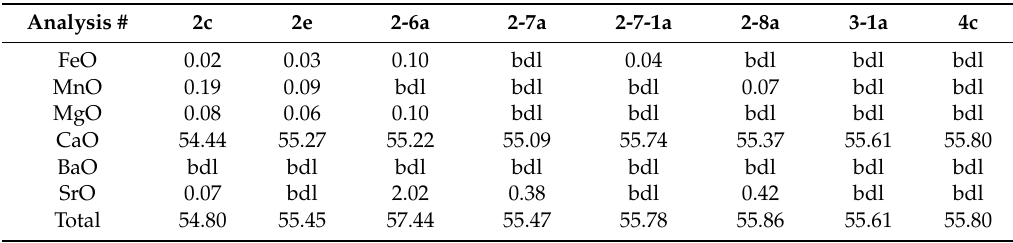
Figure 6. BSE images showing the morphology and textural relationships of minor, accessory and secondary minerals: ( a , b ) “Skeletal” zircon (possibly due to rapid growth); ( c ) Numerous grains of Ni-Fe sulfide (Ni > Fe, possibly godlevskite) (bright) included in saponite aggregate; ( d ) typical morphology of apatite and bent groundmass phlogopite; ( e , f ) morphology of hydroandradite crystallized after phlogopite and saponite. Mineral abbreviations as in Figures 3 and 4; in addition: Zrn = zircon, Ni-Fe-S = Ni-Fe sulfide. Table 1. Representative chemical compositions (wt.%) and mineral formulae (apfu) of carbonate from the Vinoren